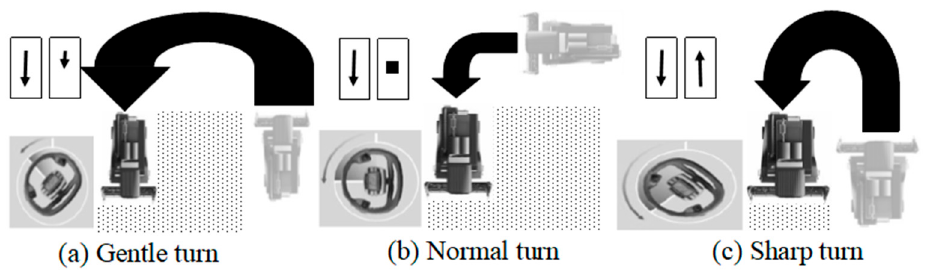
Figure 2. Combine harvester’s Fulltime Drive System (FDS) with steering wheel for 3 turning modes ( a ) Gentle turn, ( b ) Normal turn, ( c ) Sharp turn.